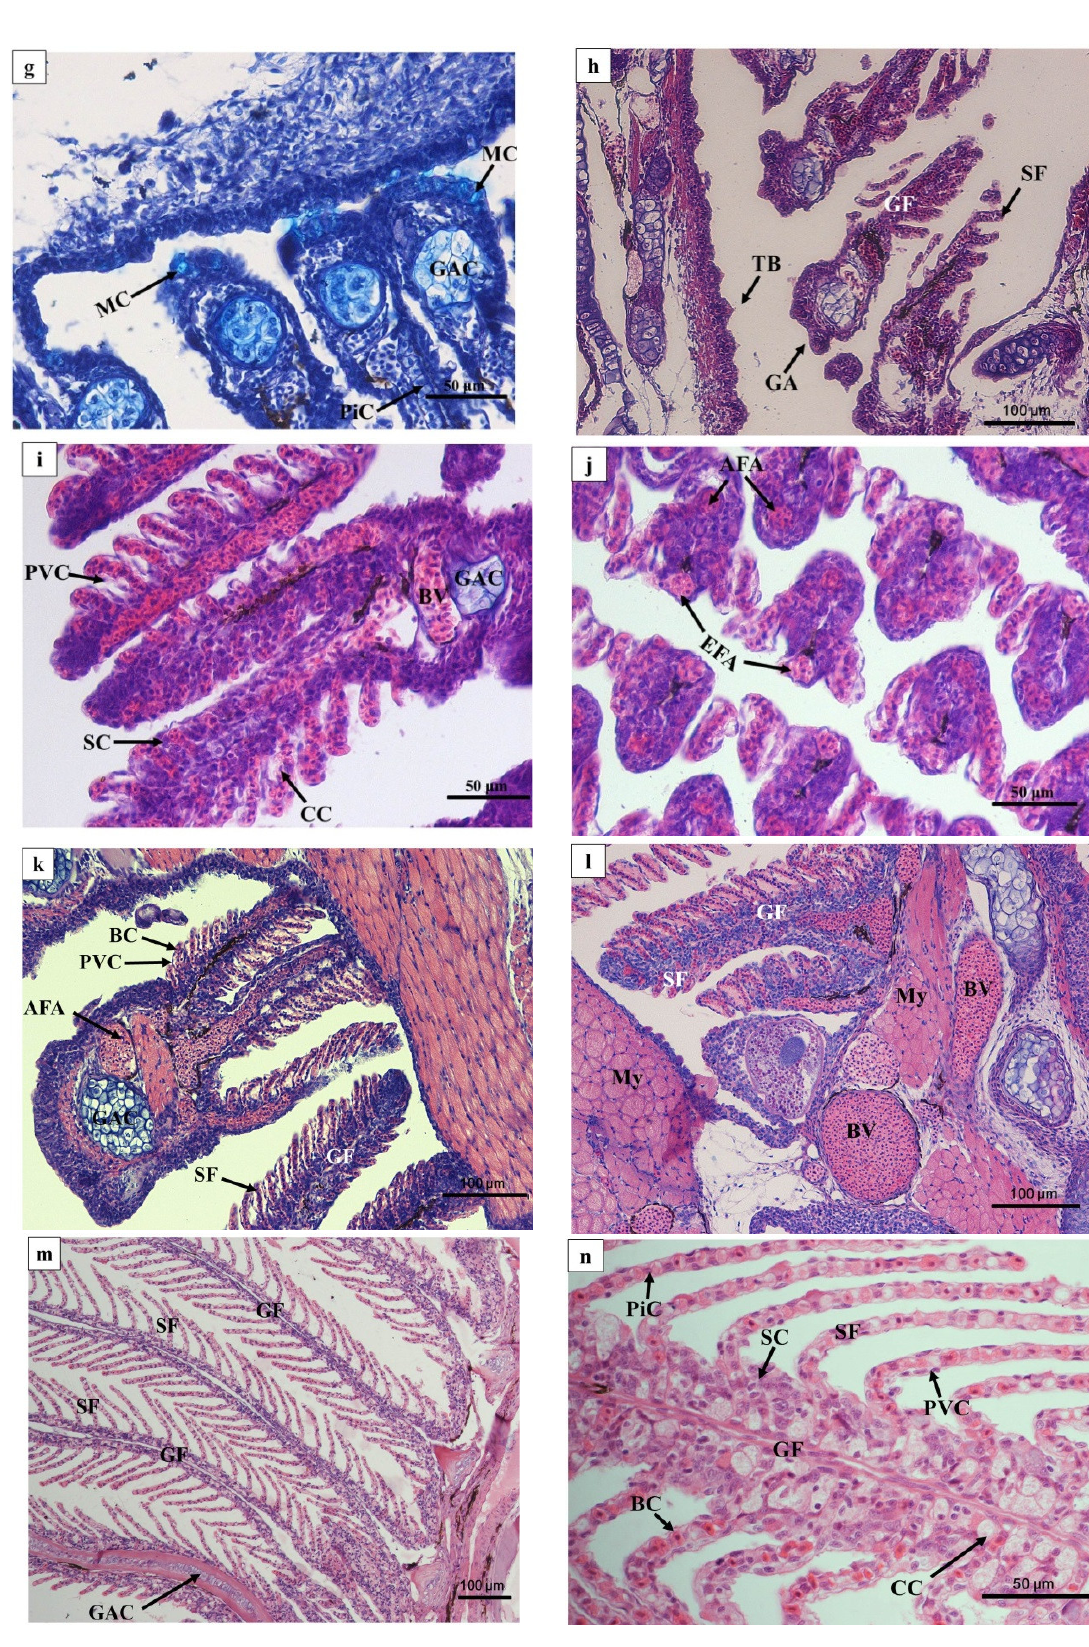
Figure 3. Histology of the external and internal gill development of P. dabryanus after hatching: ( a ) longitudinal section of 1 DAH larva (HE); ( b ) longitudinal section of 2 DAH larva (HE); ( c ) longitudinal section of 3 DAH larva (AB-PAS); ( d ) longitudinal section of 5 DAH larva (HE); ( e ) longitudinal section of 7 DAH juvenile (HE); ( f ) longitudinal section of 12 DAH juvenile (HE); ( g ) longitudinal section of 12 DAH juvenile (AB-PAS); ( h ) longitudinal section of 15 DAH juvenile (HE); ( i ) longitudinal section of 20 DAH juvenile (HE); ( j ) cross-section of 25 DAH juvenile (HE); ( k ) cross-